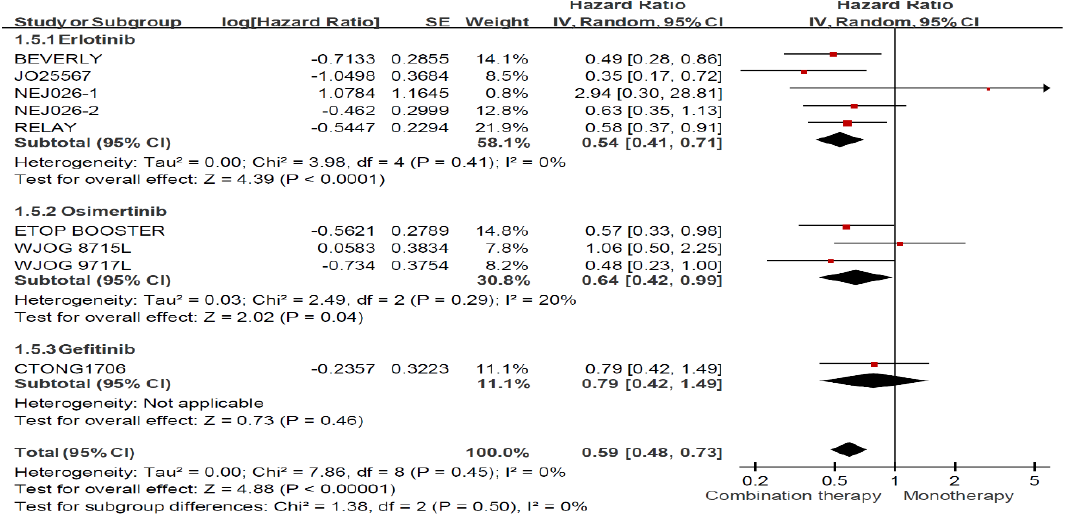
Figure 4. Forest plot and pooled hazard ratio for progression free survival (PFS) in the ever smoker subgroup (Stratified by regimen).